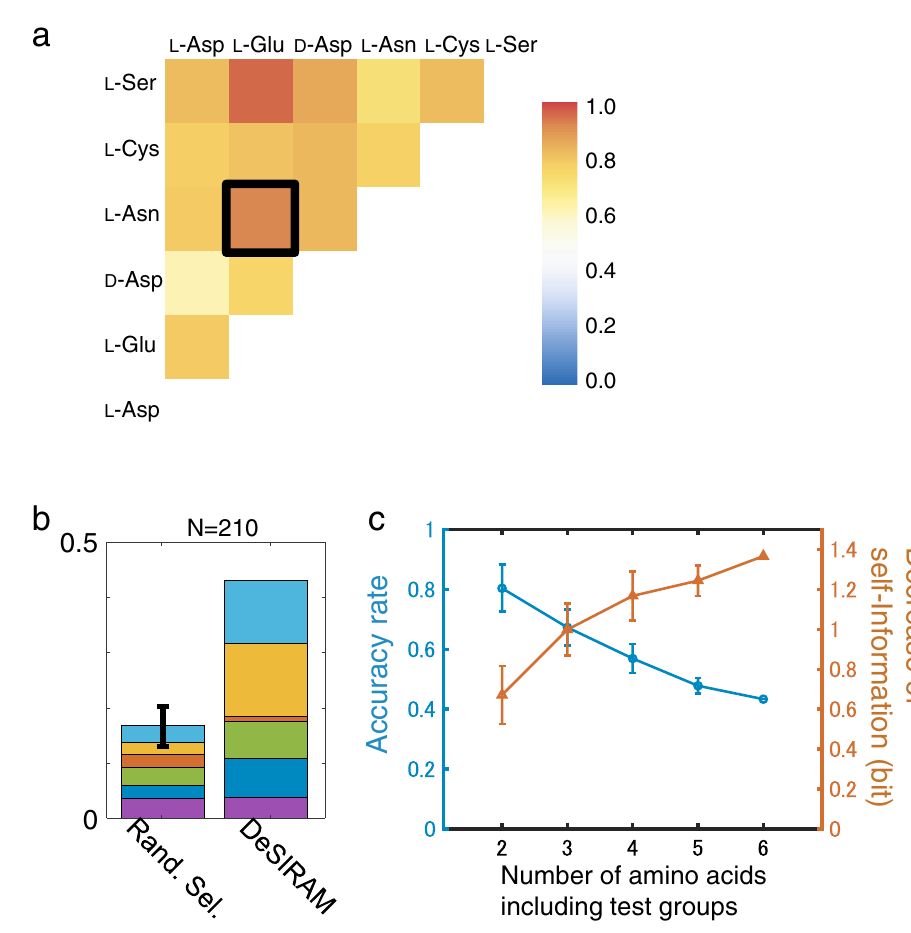
Figure 3. Discrimination of various attractants with DeSIRAM. ( a ) Accuracy rate spectrum of decipherment of chemical types of blind samples using DeSIRAM. Accuracy rates of decipherment of 15 groups consisting of 2 of 6 standard attractants. Vertical and horizontal axes indicate attractants included in the tested group. Six amino acid attractants are numbered arbitrary, l-Asp (1), l-Glu (2), d-Asp (3), l-Asn (4), l-Cys (5) and l-Ser (6). Black square shows data of Fig. 2d. ( b ) Accuracy rate of decipherment for attractant groups consisting of 6 standard attractants: l-Asp (dark blue), l-Glu (purple), d-Asp (red), l-Asn (green), l-Cys (yellow) and l-Ser (light blue). The left bar shows theoretical accuracy rate of RS ( ≅ 1/6 = 0.17). The black line on the left bar shows the standard deviation calculated numerically (= 0.04, see SI for details). The right bar shows accuracy rate by DeSIRAM. The decipherment accuracy of 0.43 is high relative to that by RS. The probability of an identification success rate of 0.43 by RS is 1.3 × 10 −19 . ( c ) Dependencies of accuracy rate (blue makers) and DSI (red markers) on number of attractant (NA) including in the tested groups. Plotted values are presented as averages and error bars indicated the standard deviations (n = 15, 20, 15, 6, 1 for NA = 2, 3, 4, 5, 6, respectively). Numbers of data (N) varies with NA. Here, 6 amino acids were prepared as standard attractants. For instance, in groups consisting of three amino acid attractants, N becomes 6 C 3 = 20. The DSI of each group was